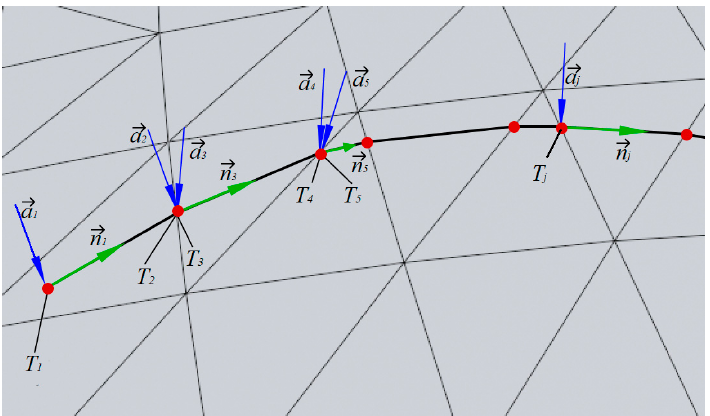
Figure 5. A triangulation model of a seabed surface and the formed motion trajectory of the MM working tool.